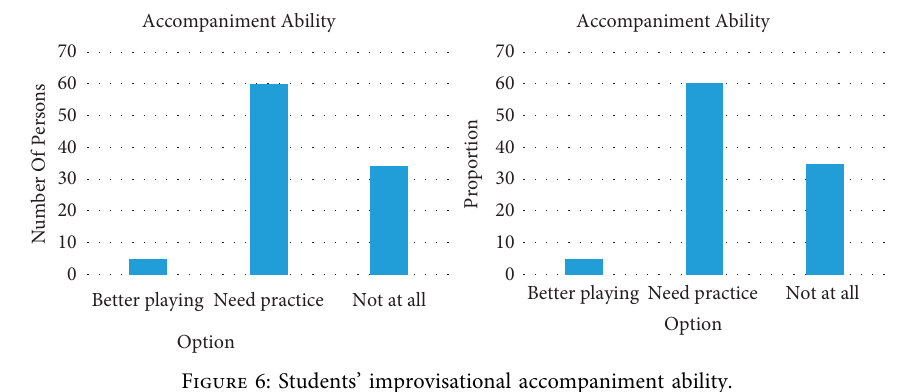
Figure 6: Students’ improvisational accompaniment ability.